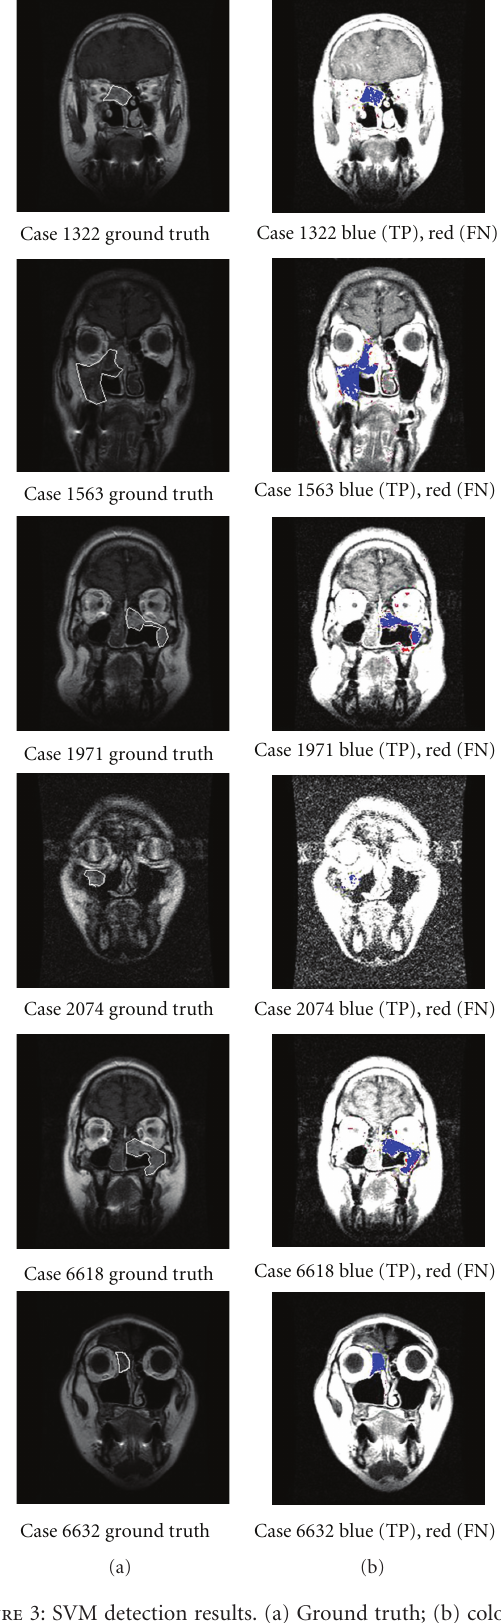
Figure 3: SVM detection results. (a) Ground truth; (b) color blue is for true positive and color red is for false